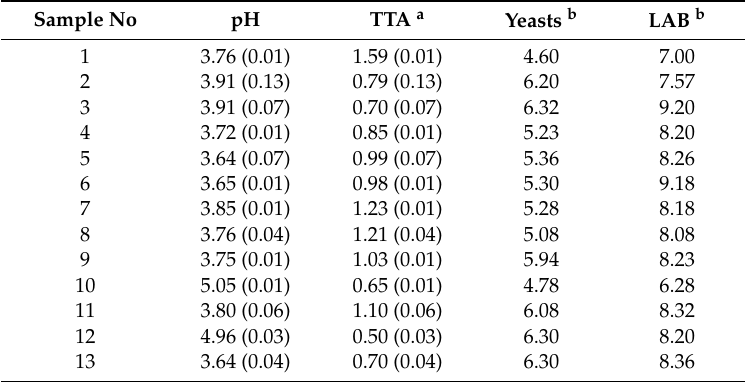
Table 2. Physicochemical and microbiological data of 13 Greek wheat sourdoughs.